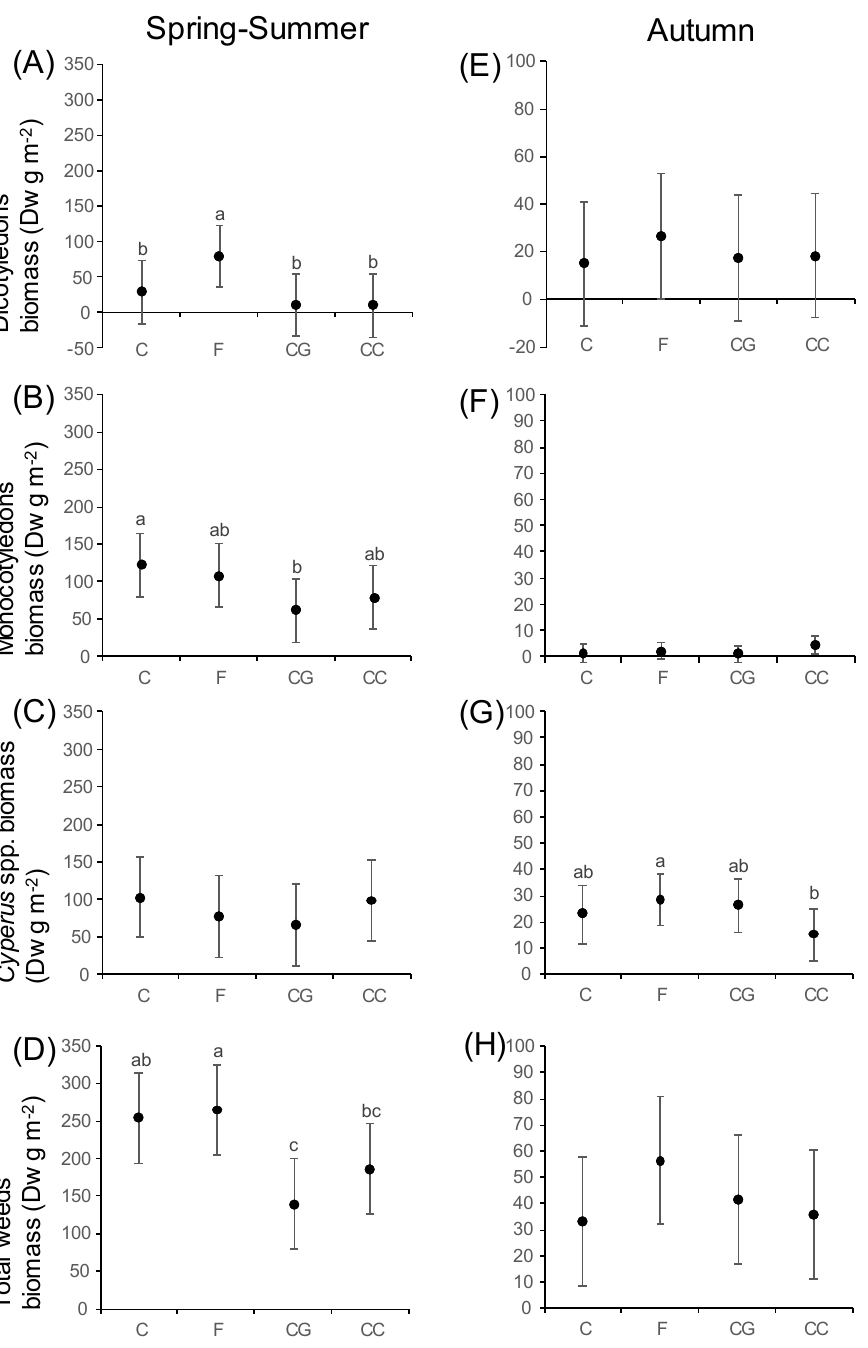
which increased in CG plots at week four, but rapidly decreased in CG and F plots at week eight compared with the control plots (Table 4).